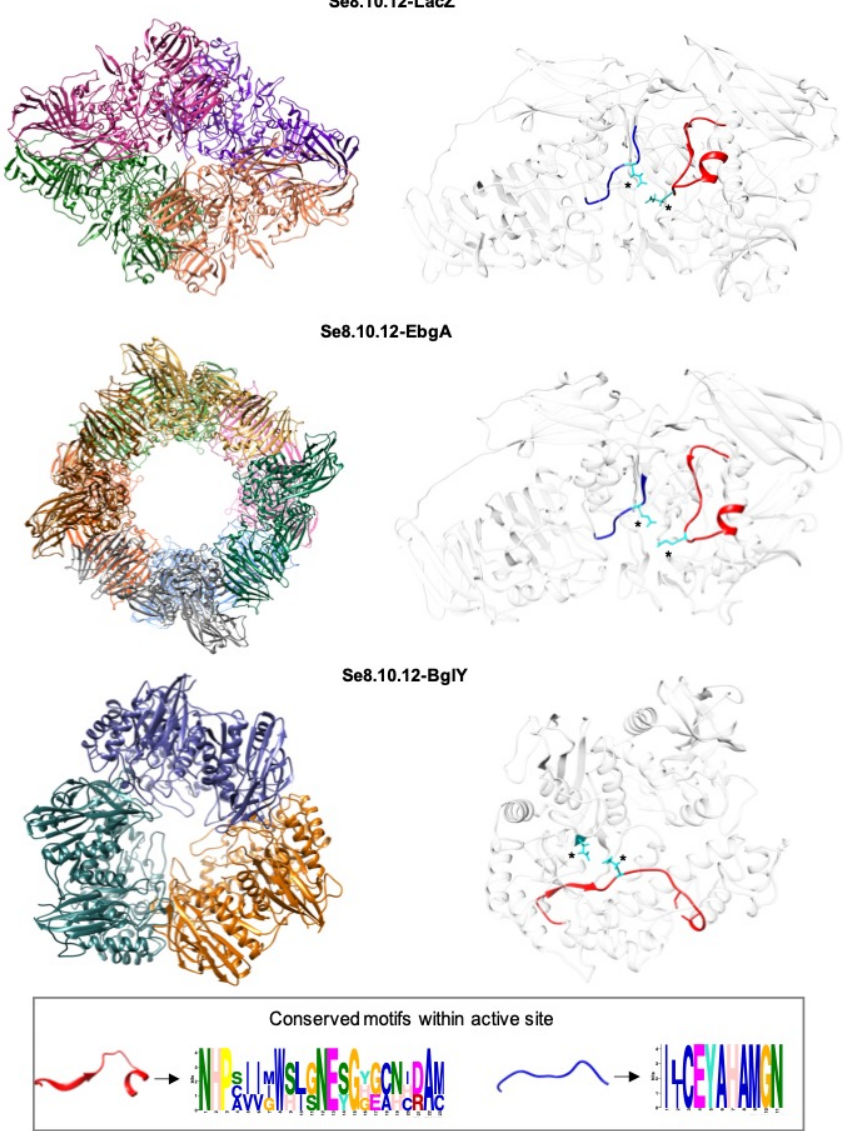
Figure 8. Overall predicted structure of the Rahnella inusitata Se8.10.12 β -galactosidases. The three- dimensional structure reconstructed by homology modeling is presented as a ribbon model. The reconstruction shows quaternary structure ( left ) and monomeric ( right ) views. In the monomers, the catalytic motifs are colored in red and blue, while asterisks indicate the glutamic acid amino acid in the active site.